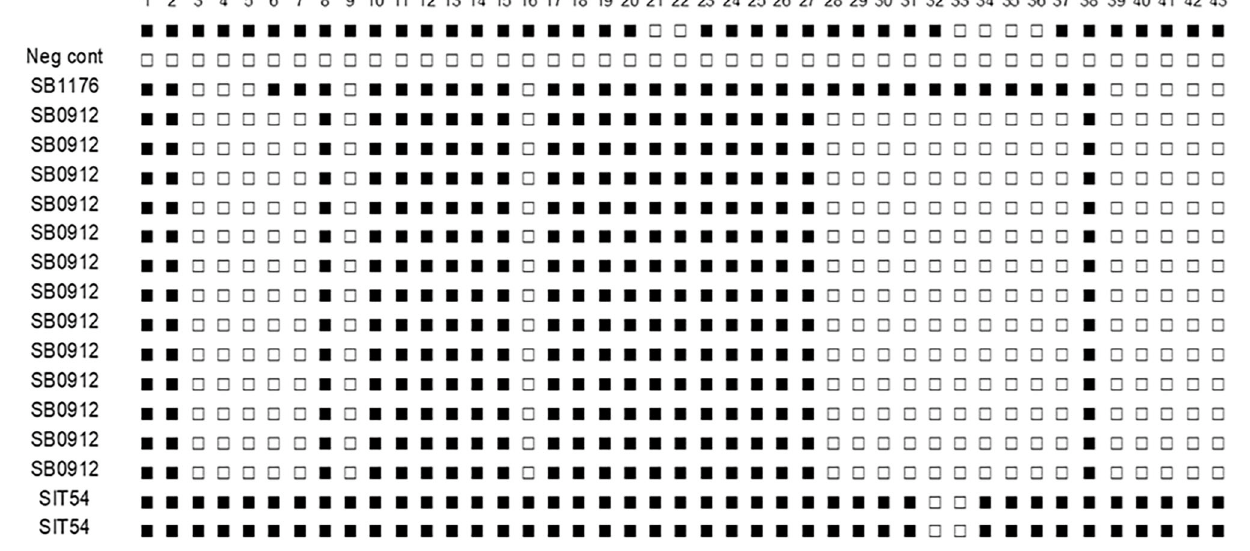
FIGURE 6 | Spoligotype patterns of isolates of M. tuberculosis and M. bovis from cattle TB lesions in central Ethiopia. All of M. bovis isolates had the spoligotype pattern of SB0912 while the two M. tuberculosis had the spoligotype pattern of SIT54. SB1176 is positive control and H 2 O a negative control. The white rectangles indicate negative signals and the black rectangles represent a positive